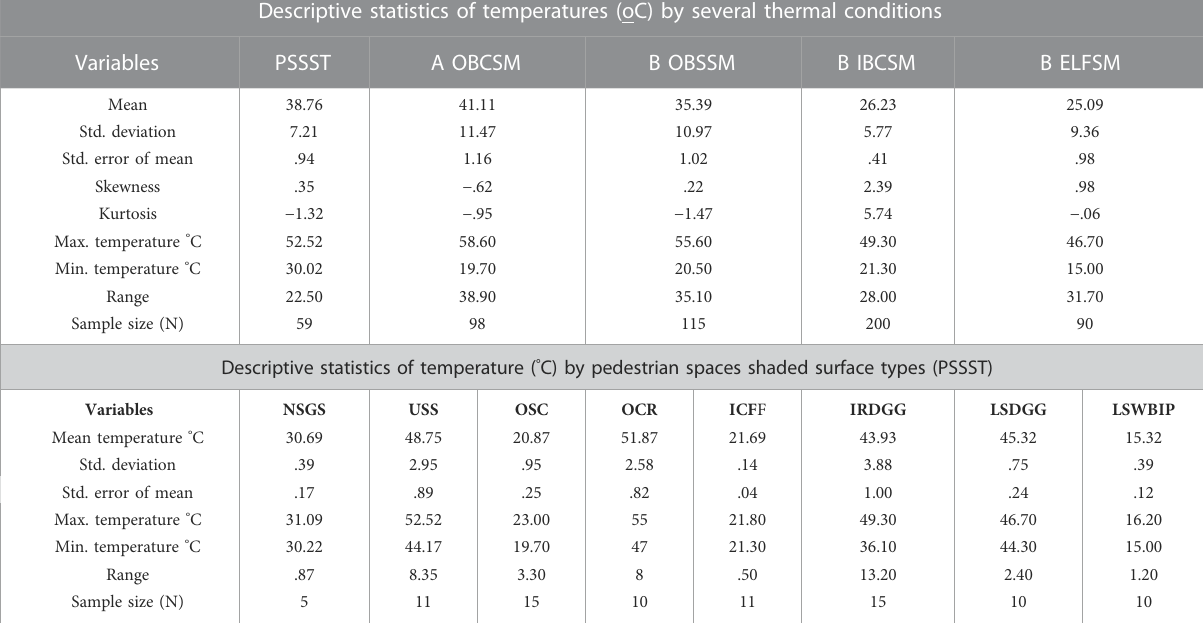
TABLE 4 Descriptive statistics of temperatures ( ° C) by several thermal conditions and by pedestrian spaces shaded surface types (PSSST). Descriptive statistics of temperatures (oC) by several thermal conditions